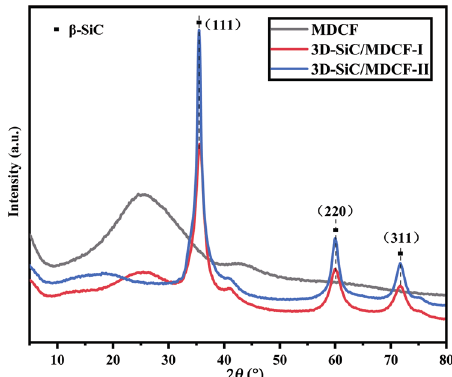
Fig. 3 XRD spectra of MDCF, 3D-SiC/MDCF-I, and